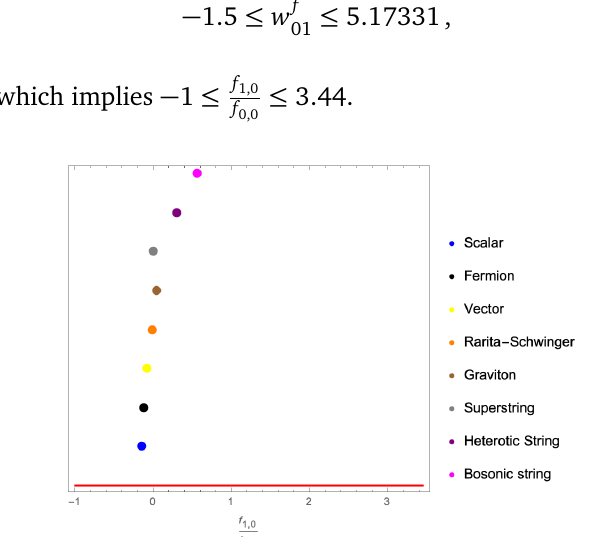
vs f with scalar, fermion, 1,0 0,0